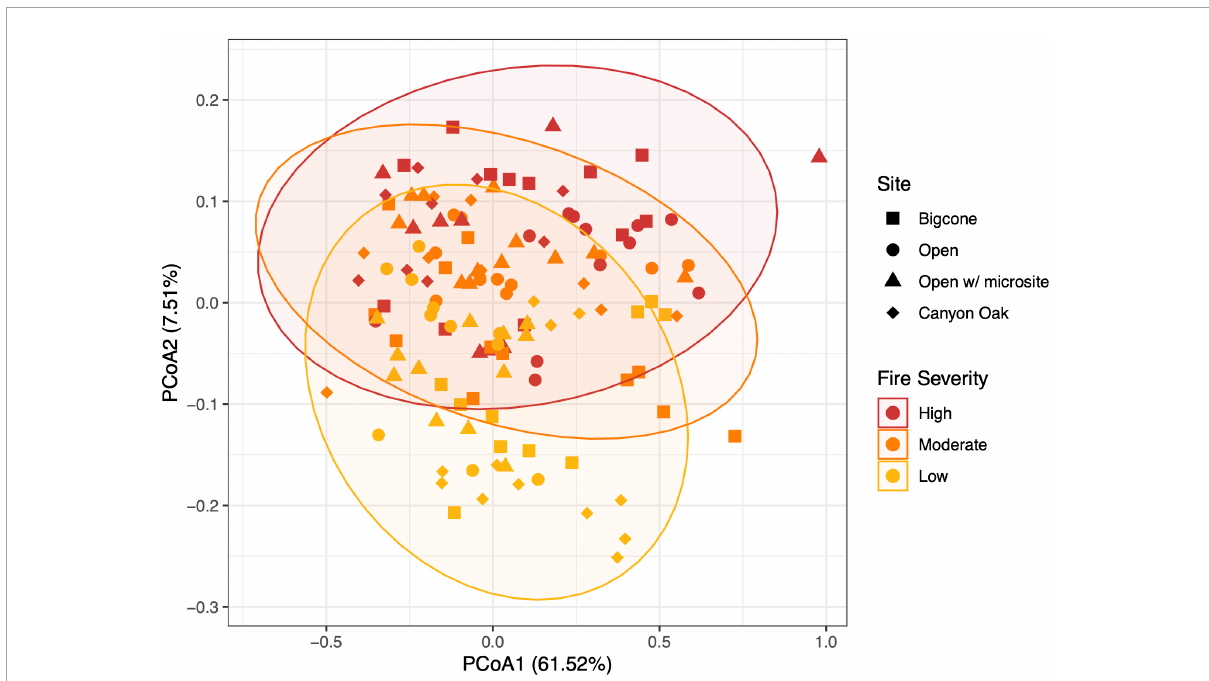
FIGURE5 Principal coordinates analysis (PCoA) of soil fungal communities. Soil fungal community data from within each of the planting sites. Bray–Curtis dissimilarity was used to differentiate the community compositions. Shading and point shapes are used to distinguish fire severity and microenvironment, respectively. Ellipses represent the 95% confidence interval for each fire severity